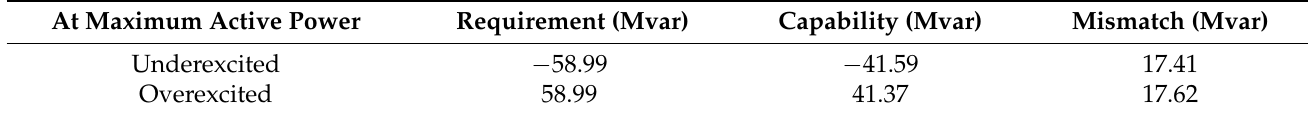
Table 1. Simulation results from the DIgSILENT model without PPC set